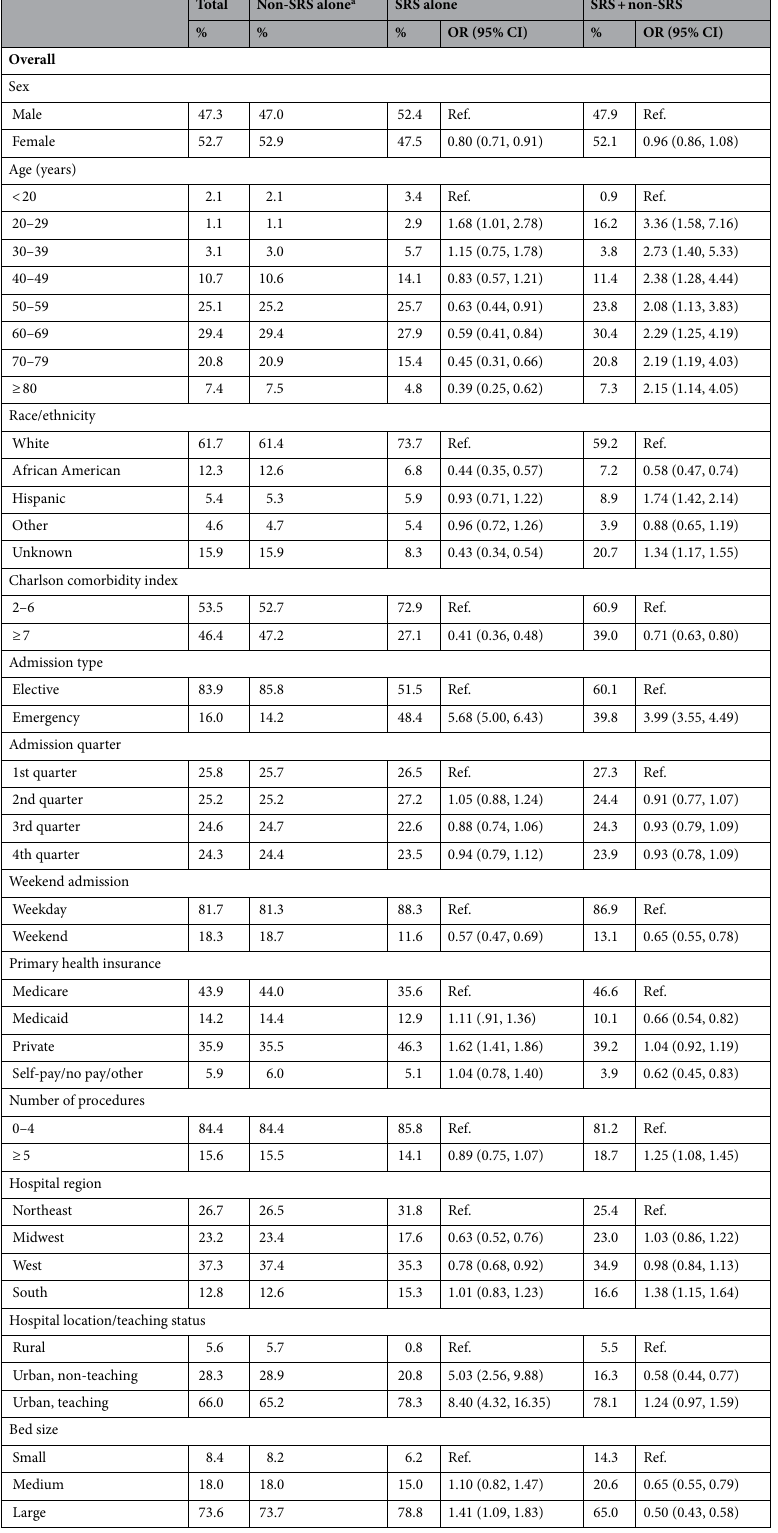
Table 1. Recipients of non-SRS alone, SRS alone and SRS + non-SRS for the treatment of brain metastases by patient and hospital characteristics—2005–2014 Nationwide Inpatient Sample (n = 35,199). CI confidence intervals, OR odds ratio, SRS stereotactic radiosurgery. a